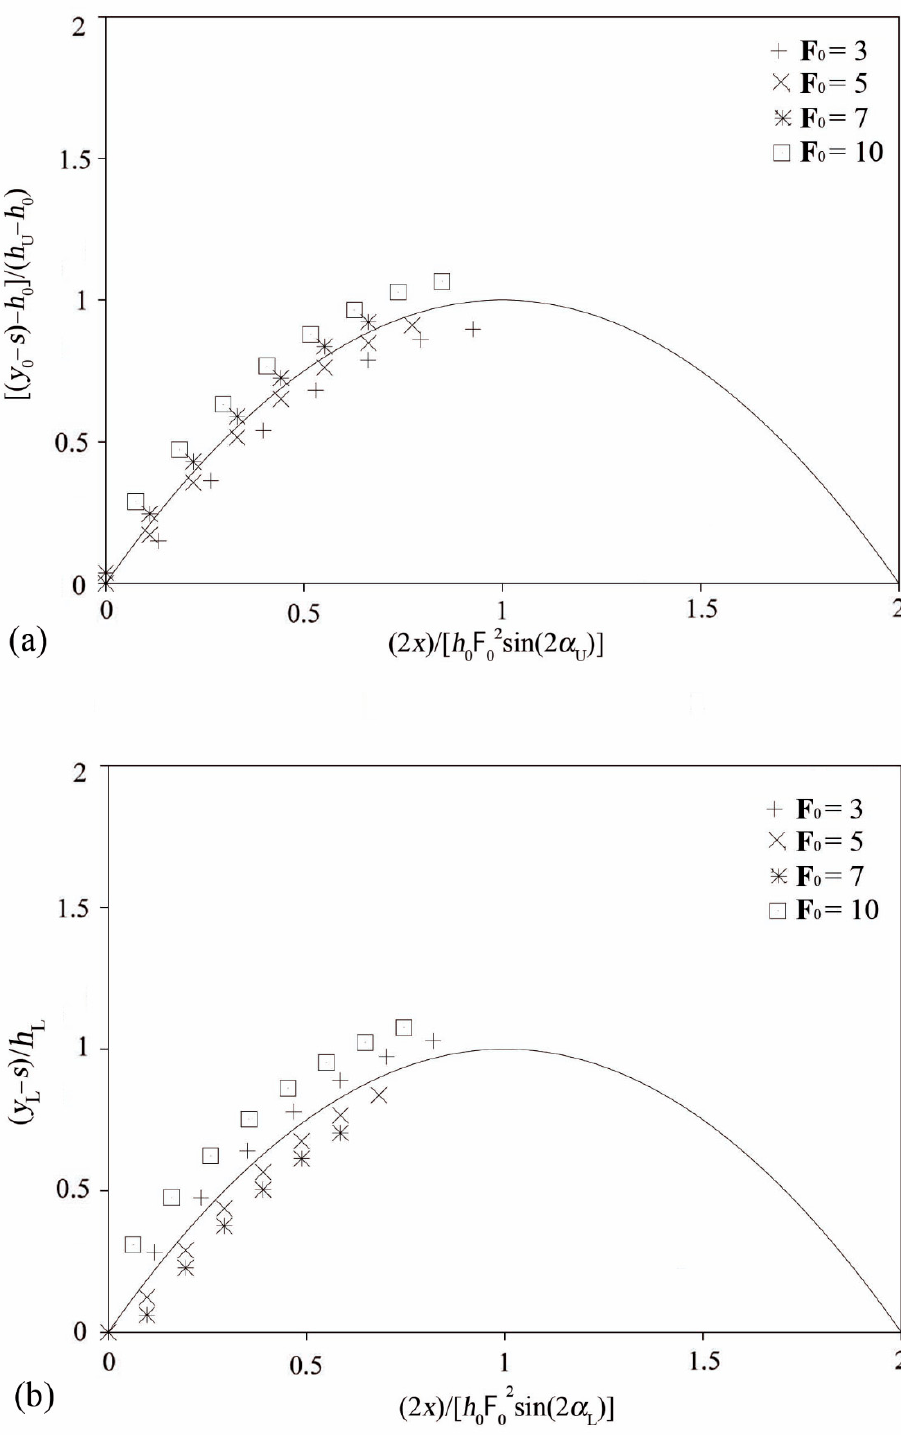
Figure 4. ( a ) Upper jet trajectory: (—) calculated by Equation (7) in [18] versus the computed values in the present study (symbols); ( b ) lower jet trajectory: (—) calculated with Equation (7) in [15] versus the computed values in the present study (symbols).